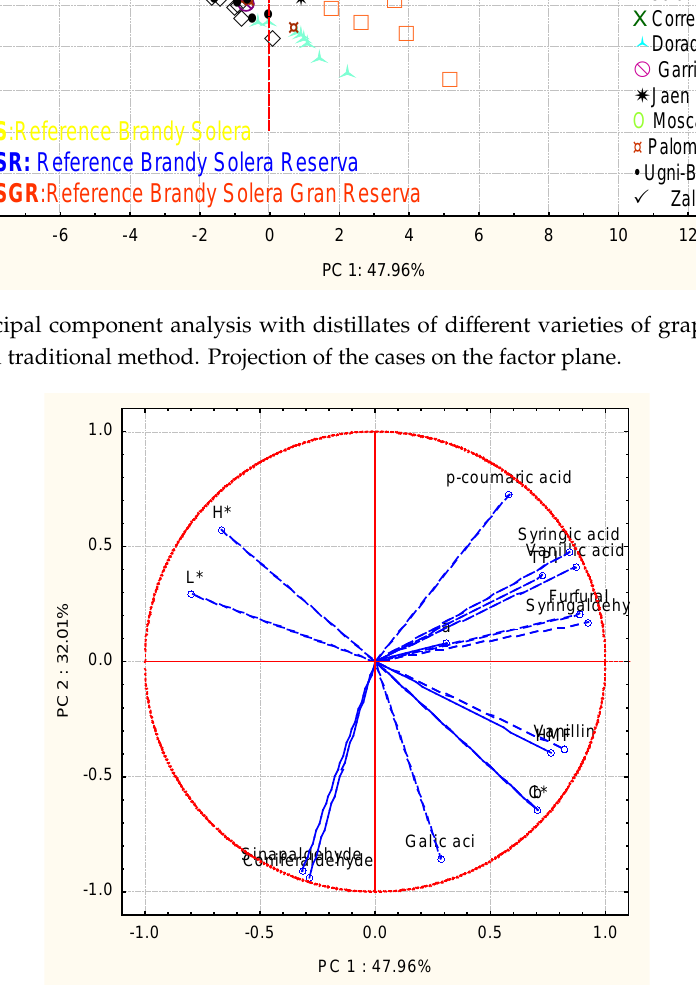
Figure 5. Principal component analysis. Projection of the variables on the factor plane.